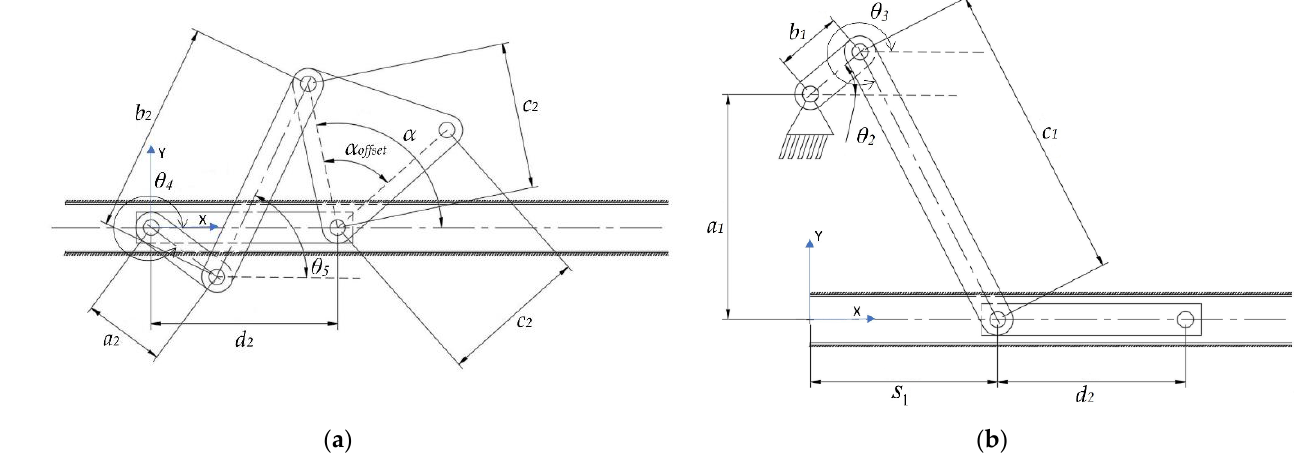
Figure 8. Pharyngeal jaw: ( a ) squeezing action mechanism; ( b ) translation action mechanism.